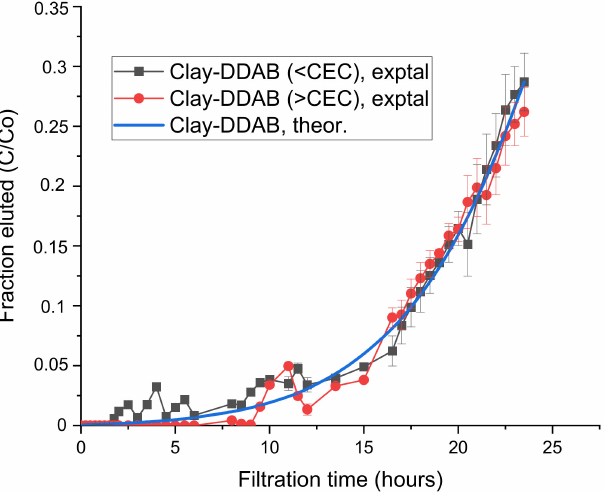
Figure 3. Eluted fractions of alachlor and its modeling in filtration experiments including clay– DDAB complexes.